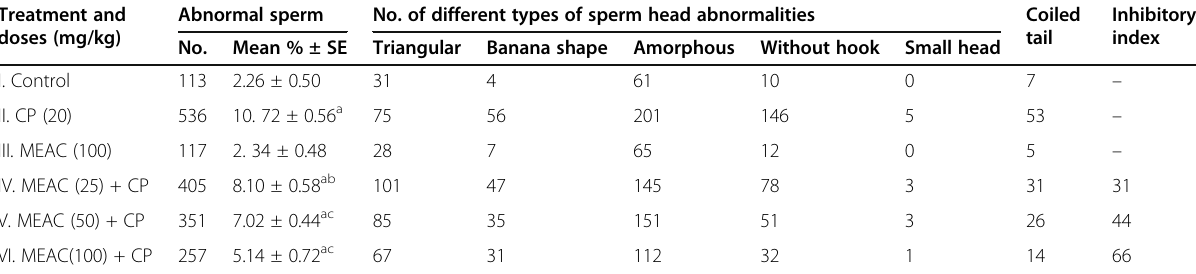
Table 3 Frequency of sperm abnormalities induced after treatment with CP and MEAC Treatment and doses